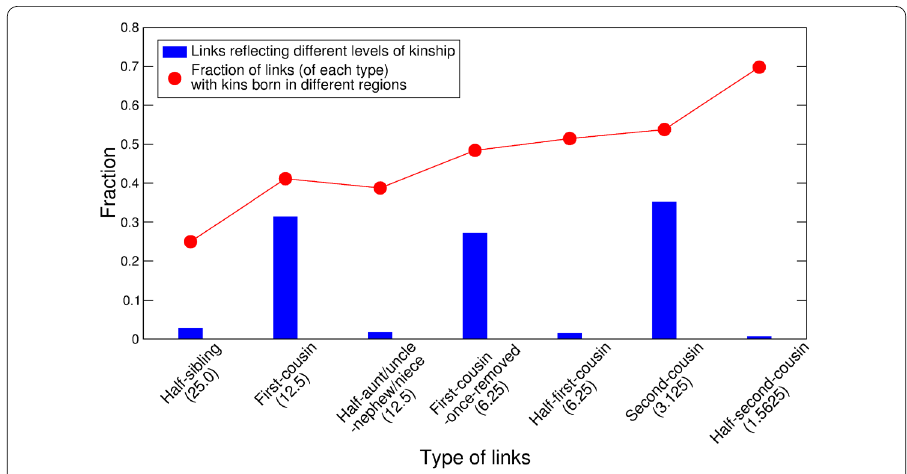
Figure 7 Nature of kin ties. The fraction of different types of links present in the network of kins is indicated by the bars. For a given type of kinship, the circles indicate the fraction of cases (out of the total in each case) when the individuals in the pair were born in different regions. The coefficients of relationship (%) are indicated inside the